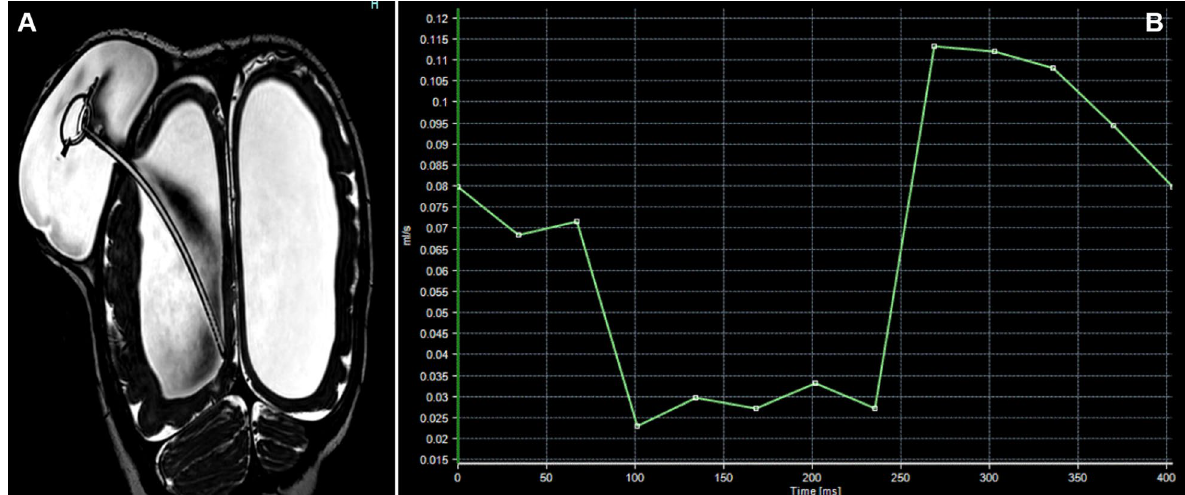
Fig. 10 A 9‑month‑old girl presented with scalp swelling. A Reconstructed 3D‑DRIVE in coronal oblique plane shows fluid collection surrounding shunt reservoir near skull burr hole; the proximal catheter and reservoir are seen patent with no evidence of disconnection. Turbulent CSF flow‑related artifact is noted within the ventricular system and fluid collection as well (appreciated in FLAIR sequence, not shown). B CSF flow curve shows high flow rate values (flux: 0.1